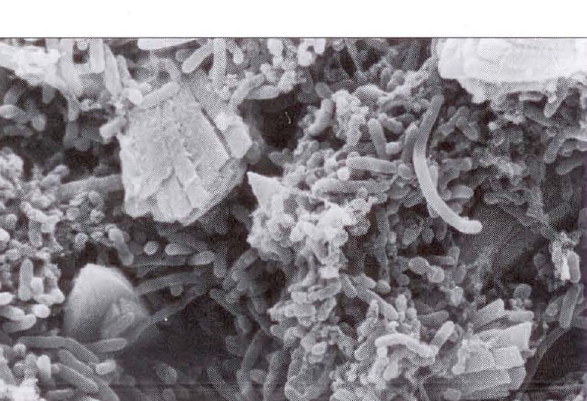
Figure 6) Scanning electron micrograph of the swface of an encrusted catheter shows rod-shaped and coccoid bacte1ial cells among dehydration condensed residue of the enveloping ex· opolysaccharoid glycocalyx and uromucoid ·slime·. Discrete crystals are noted within this coherent biojilm. The association of bacteria. slime and crystals leads to eventual obstruction in the catheter. Bar 5 ,,m. (Reproduced with permission from r~{er· ence